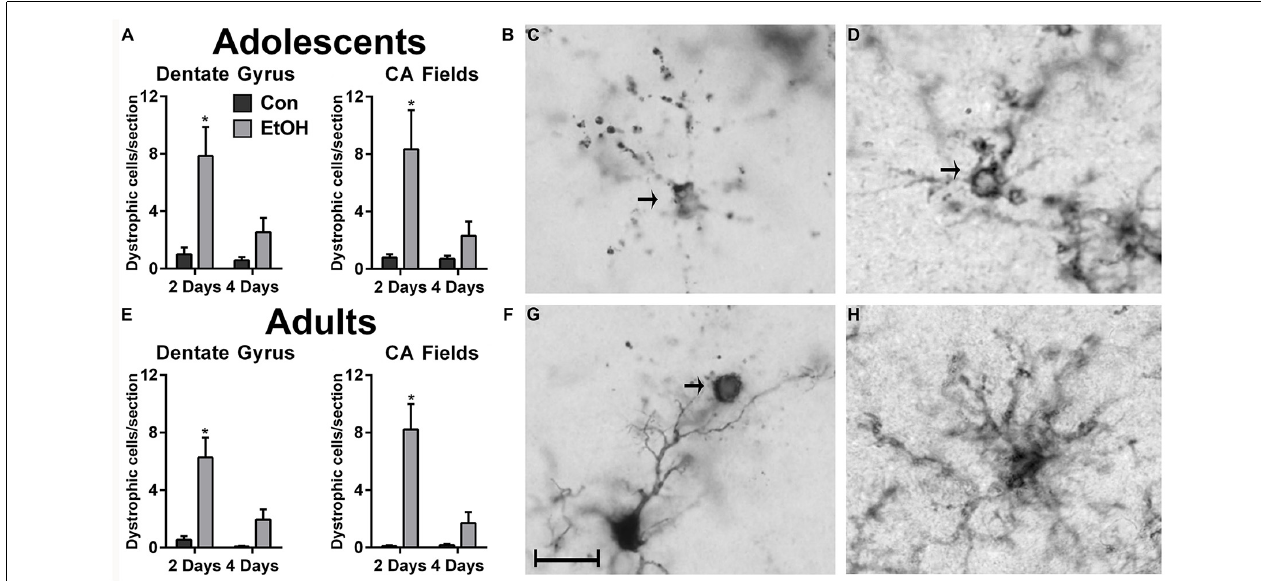
FIGURE 3 | Ethanol increases the number of dystrophic microglia. Rats exposed to ethanol had more Iba1+ dystrophic microglia in both adolescents (A,B) and adults (E,F) compared with the controls. Arrows in photomicrographs indicate Iba1+ dystrophic microglia as signified by beaded processes and/or cytorrhexis in panels (C,D,G) . Although dystrophic cell counts were based on Iba1+ cells, a secondary microglial marker, OX42, also showed the presence of cytorrhexis in 4-day binge ethanol exposed adult rats (D) compared with a normal ramified microglial cell in adult controls (H) . Data are mean ± SEM. Scale bar = 20 µ m, * p <